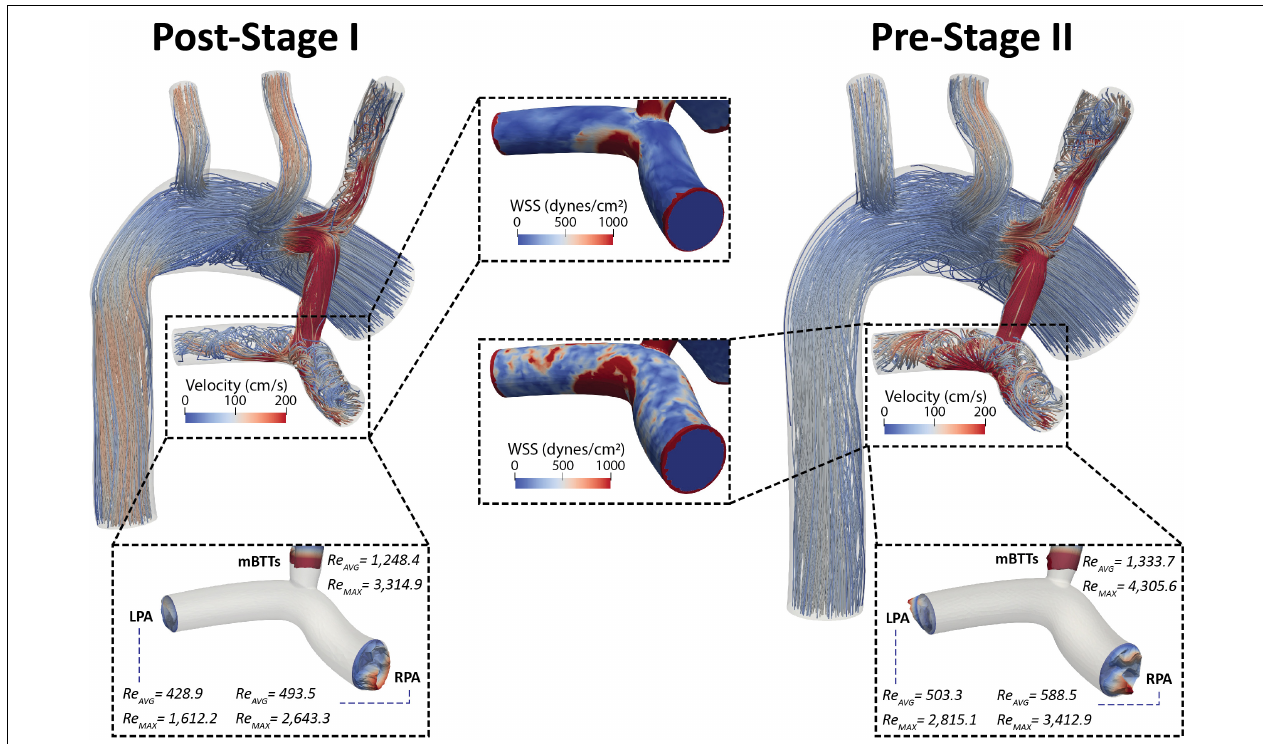
FIGURE 8 | Velocity streamlines for both post-S1 and pre-S2 models during peak systole ( t = 0.21 s). Disturbed flow patterns are prominent at the mBTTs-PA anastomosis and propagate throughout the PAs. Surface plots of WSS (center) in the PAs are presented for both models. There are concentrations of high WSS where the mBTTs flow impacts the wall of the PA. The WSS experienced in the PAs slightly increases during the interim period between stage I and II. Finally, velocity profiles at the mBTTs, LPA, and RPA (bottom) and their corresponding time average and peak systolic Reynolds numbers. High Reynolds numbers ( > 2,000) are indicative of turbulence and can be seen within the mBTTs and PAs. These Reynolds numbers increase from post-S1 to